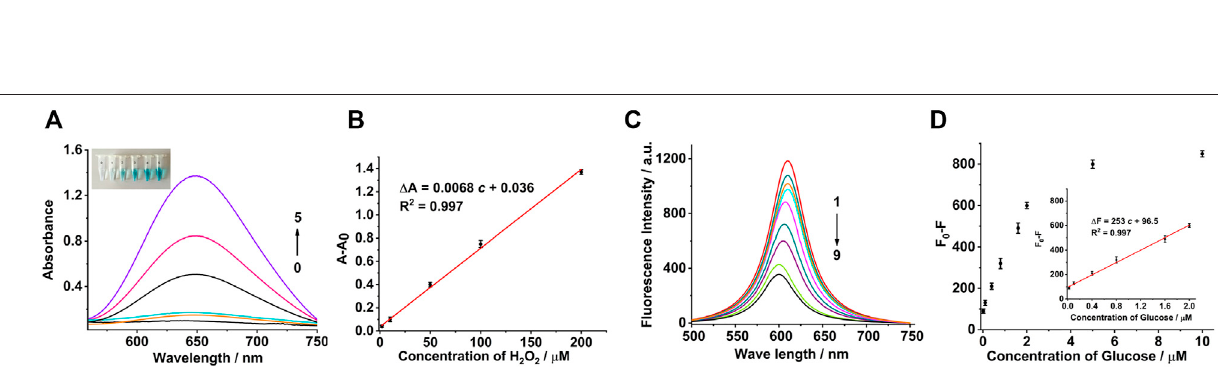
FIGURE 3 | (A) Absorbance spectra of TMB under different conditions: (a) TMB, (b) Co 3 O 4 + TMB, and (c) Co 3 O 4 + TMB + H 2 O 2 (B) Fluorescence spectra of Ru (bpy) 32+ under different experimental conditions: (a) Ru (bpy) 32+ ; (b) Co 3 O 4 + TMB + H 2 O 2 + Ru (bpy) 32+ ; and (C) Fluorescence quenching mechanism. The concentrations of Co 3 O 4 , TMB, H 2 O 2, and Ru (bpy) 32+ were 20 μ g/ml, 0.5, 0.05, and 0.5 mM, respectively.